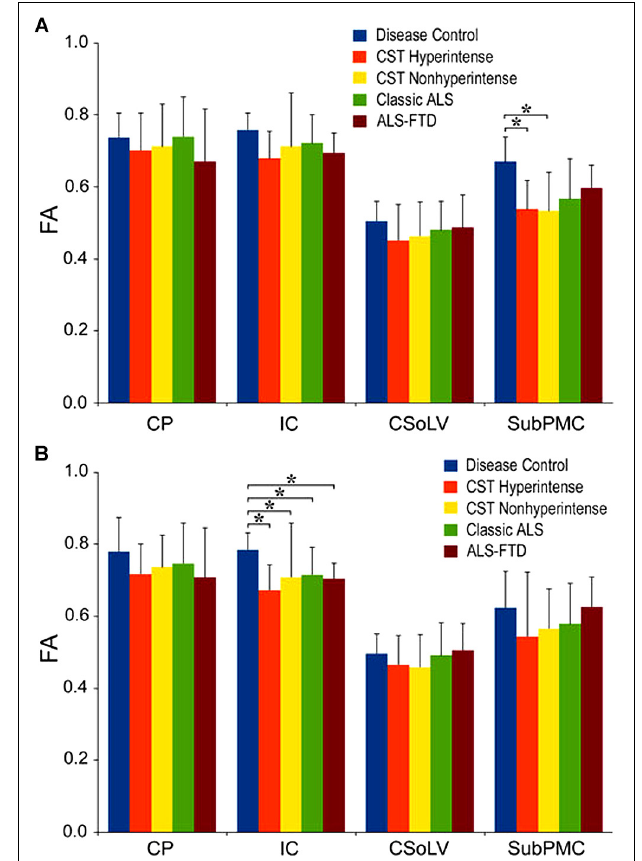
FIGURE 2 | Fractional anisotropy (FA) values at four CST levels in left (A) and right (B) hemispheres of ALS patients compared to controls showing significant differences as ∗ P < 0.05. CP, cerebral peduncle; IC, posterior limb of internal capsule; CSoLV, centrum semiovale at top of lateral ventricle; subPMC, subjacent to primary motor cortex. Reproduced with permission from Springer